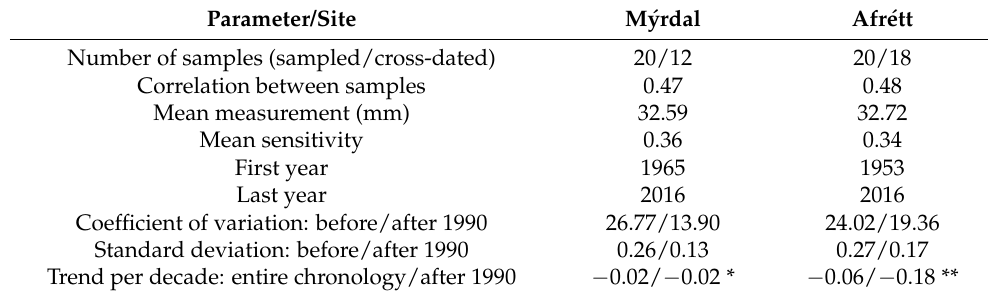
Table 2. Dwarf willow sites sampled in Iceland and corresponding chronology information. Parameter/Site Number of samples (sampled/cross-dated)